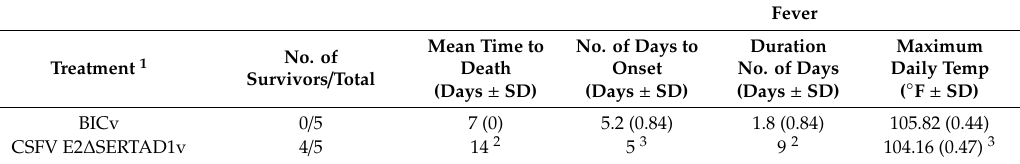
Table 1. Swine survival and fever responses in animals infected with mutant E2 ∆ SERTAD1v compared with those infected with parental